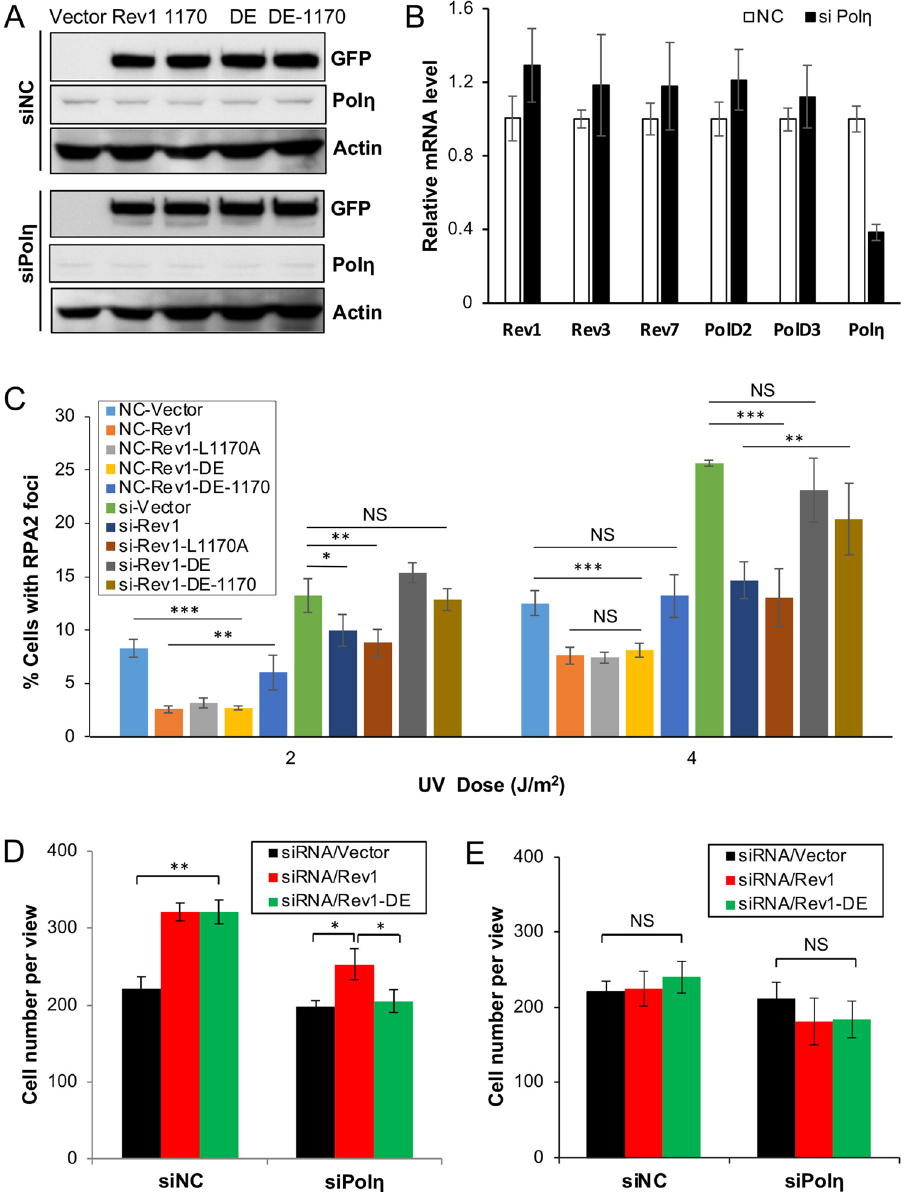
Figure 2. Rev1 and Polη play alternative roles at the insertion step of TLS. ( A ) Western blot analysis of GFP- mRev1 and its mutant transfectants in 293T cells. Cells were transfected with siPolη or non-specific siRNA (siNC). 24 h later, these cells were transfected with plasmids expressing GFP-mRev1 or its mutant proteins. After 48 h, the transfected cells were harvested, lysed and subjected to western blotting. The two sets of gels were from the same experiment and treated under identical conditions. ( B ) Efficacy of siRNA depletion against Polη in 293T cells as measured by qRT-PCR analysis. ( C ) Effects of GFP-mRev1 or its mutant expression on UV-induced nuclear RPA2 focus formation in 293T cells with siPolη (si) or non-specific siRNA (NC) treatment. Cells were transfected with siRNA molecules in combination with GFP-mRev1 or its mutants followed by UV irradiation. Immunofluorescence assay was performed 6 h after UV irradiation. ( D, E ) Effects of Polη depletion and ectopic expression of GFP-mRev1 or GFP-mRev1-DE on 293T cell growth with ( D ) or without ( E ) UV irradiation. Cells were transfected with siPolη. 24 h later, these cells were transfected with GFP-mRev1 or its mutant plasmids, incubated for 2 days and irradiated by 20 J/m 2 UV. After 72 h of incubation, the number of viable cells were counted. Data shown in ( A , C , D, E) are means of at least three independent experiments ± SEM. *, P < 0.05; **, P < 0.01; ***, P < 0.001; NS, not significant by two-sided Student’s t